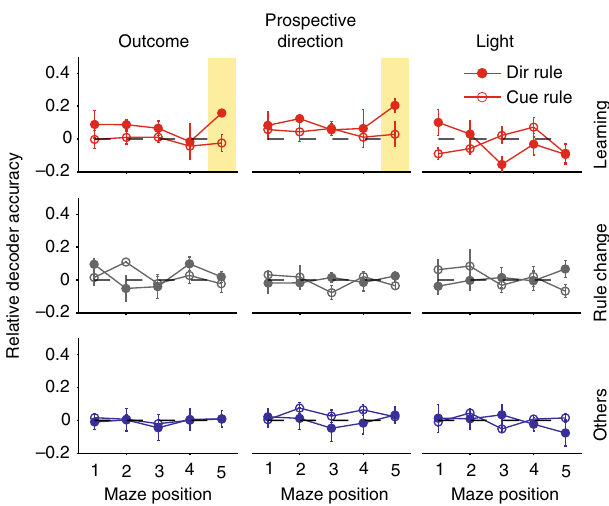
Fig. 6 No prospective encoding of outcome and choice. We plot here the relative decoder accuracy over all session types and rule types for features on the immediately following trial. Compare with Fig. 5d. Each data point is the mean ± SEM accuracy in excess of chance (dashed line) over the indicated sessions (learning, rule-change, other). As a sanity check that our cross-validation of the decoder and shuf fl ed controls were working, we also decoded the prospective light position: as this was randomised, the ensemble activity could not predict its position and so should only have been decoded at chance levels — which it was. We replot these results grouped by rule-type in Supplementary Fig.